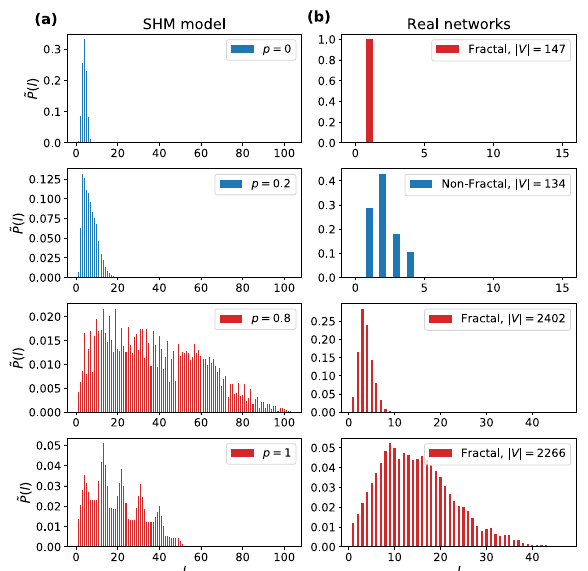
Fig. 18 Distribution of hub distances for a some cases of the Song‑Havlin‑Makse model, b some real networks. On subfigure b , for the first two subplots, two networks with similar sizes ( ∼ 140 number of nodes) are considered, and similarly to the third and fourth subplots ( ∼ 2300 number of nodes). The results for the other examined networks can be found in the supplementary material (Zakar‑Polyák et al.